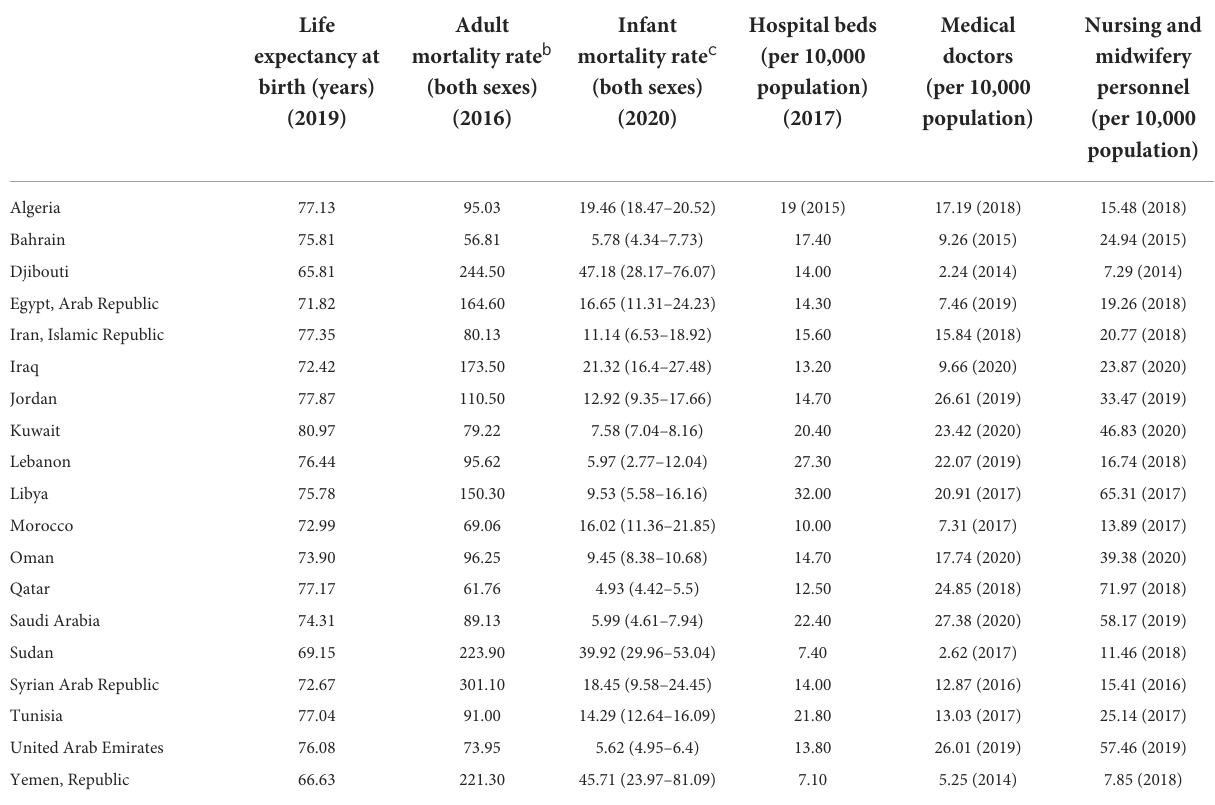
TABLE 1 Selected health indicators for some countries in the Middle East and North Africa region a . Life expectancy